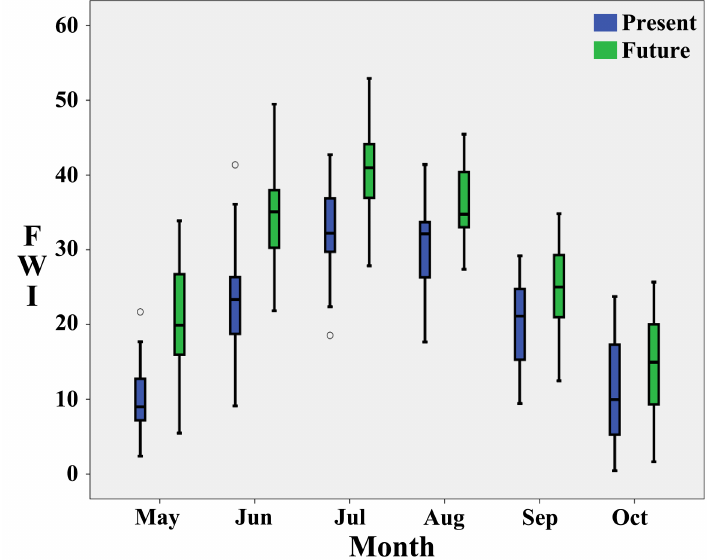
Figure 3. Fire season monthly FWI values for the present (blue) and future (green) time